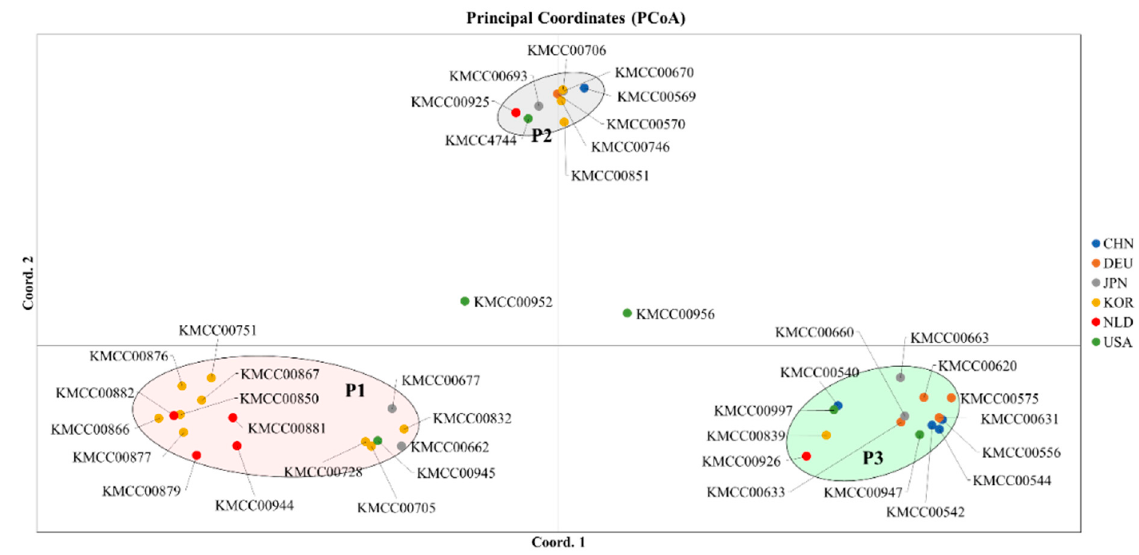
Figure 3. Principal coordinates analysis to identify the characteristics and members of each cluster.